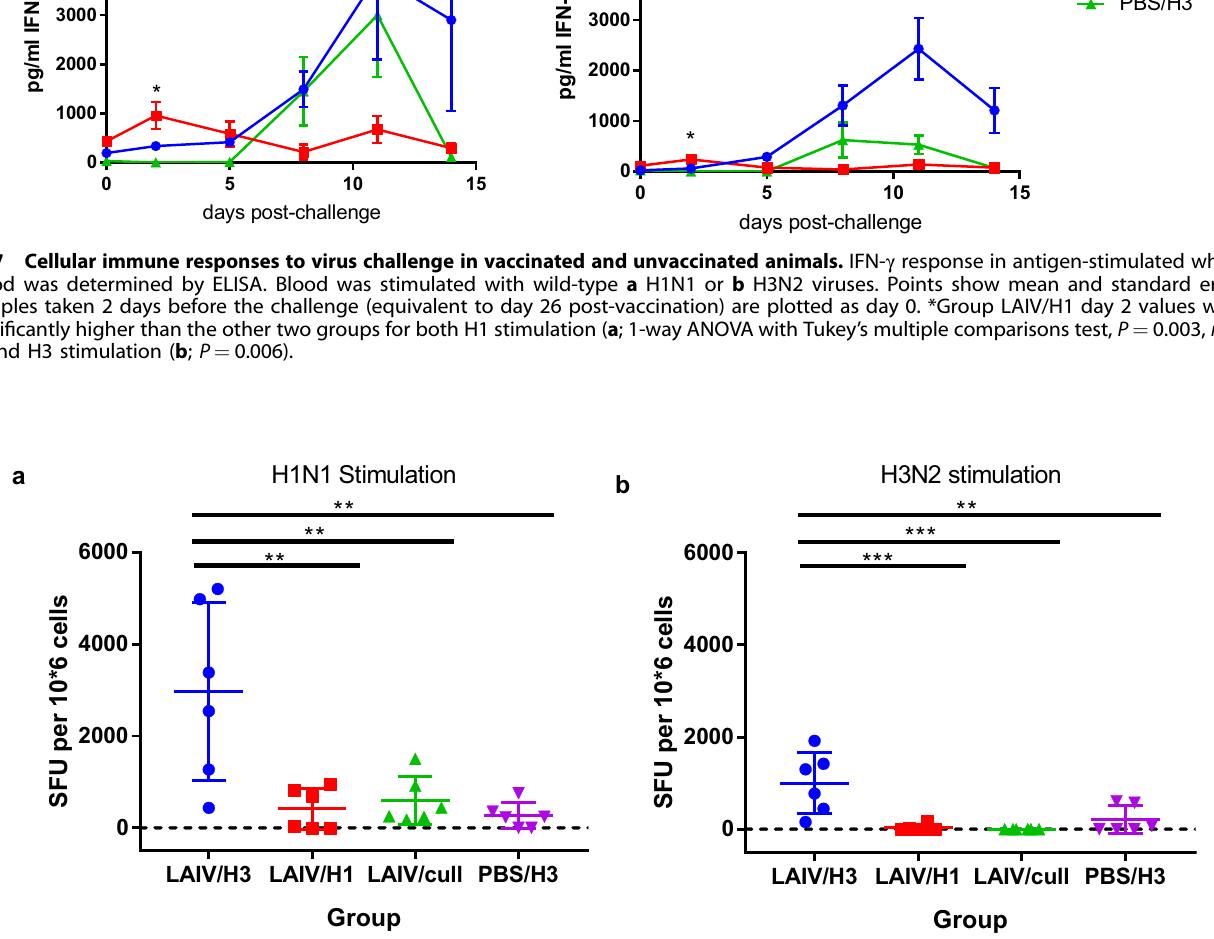
Fig. 8 Cellular immune response in lungs, measured by IFN- γ ELISpot. Puri fi ed lung lymphocytes were stimulated with a H1N1 or b H3N2 viruses. Lungs were collected at 14 dpi (groups LAIV/H3, LAIV/H2 and PBS/H3) or at 26 days post-vaccination (group LAIV/cull). Lines show group mean and SD. Groups were compared by one-way ANOVA with Tukey ’ s multiple comparisons test, n = 6. ** P < 0.01; *** P <